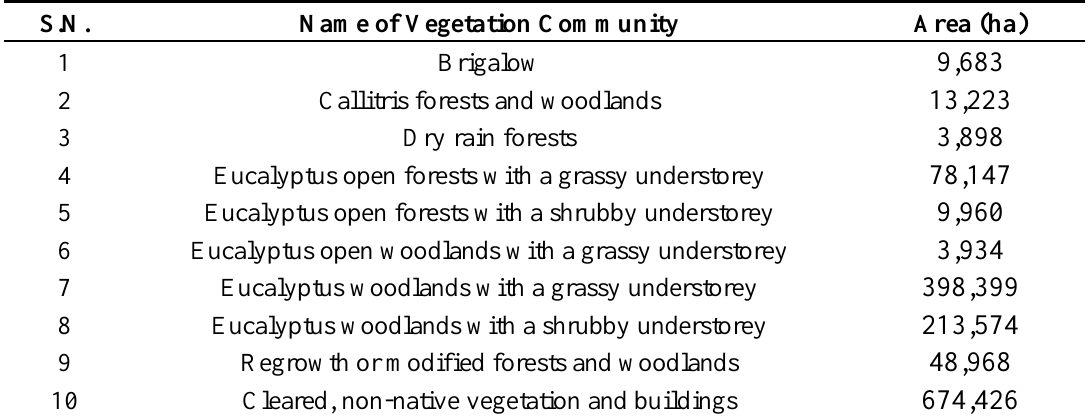
Table 1. Major vegetation sub-groups as identified by National Vegetation Information System database in the study region and their